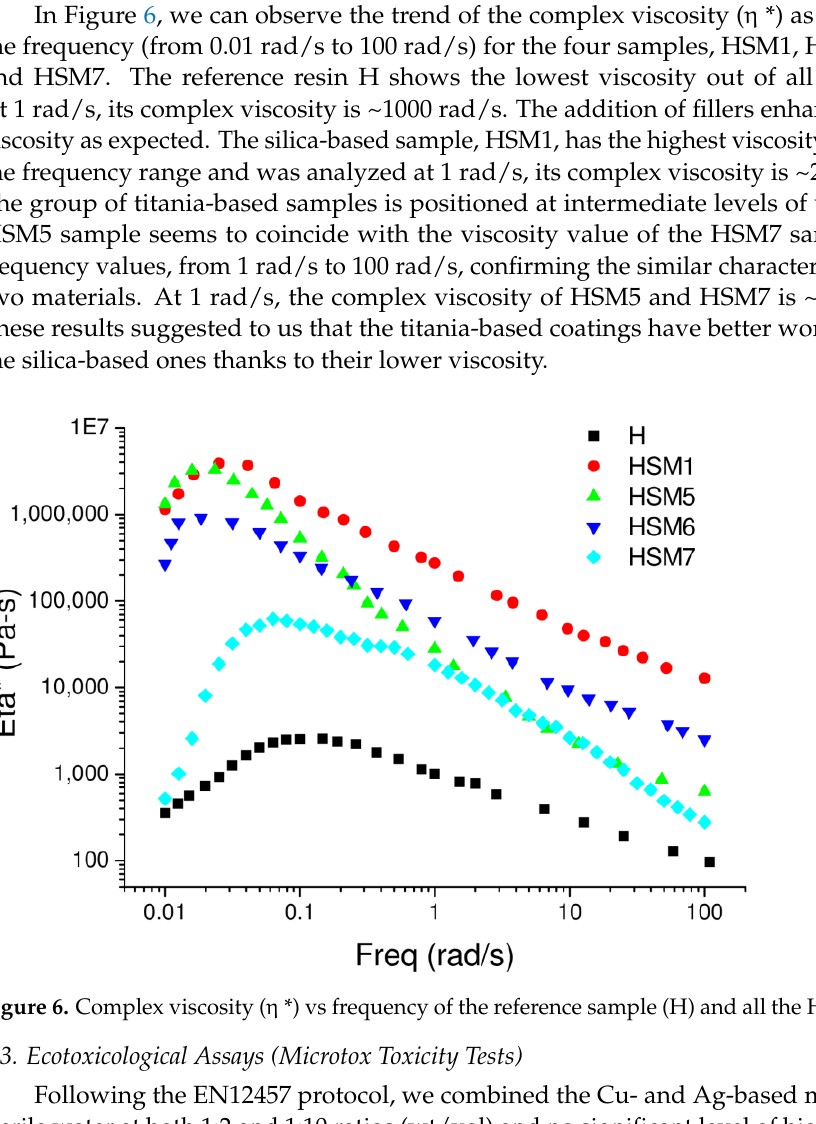
Figure 6. Complex viscosity ( η *) vs frequency of the reference sample (H) and all the HSMX coat- ings.